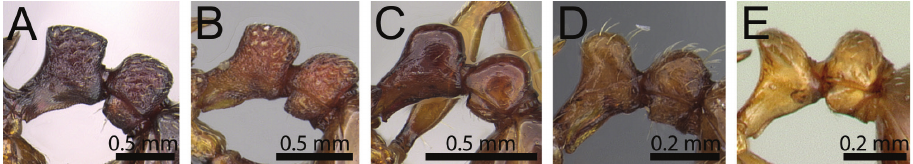
Figure 11. Petiole and postpetiole in profile. A T. fhg-ants (CASENT0248302) B T. fhg-anub (CASENT0404158) C T. nassonowii (CASENT0195504) D T. naganum (CASENT0280584) E T. arte- mis (CASENT0481732). 12 Propodeum armed with short to moderately long spines (PSLI 18–25); dor- sum of head and mesosoma without any standing pilosity (Fig. 12A, B) ....... ........................................................................ T. ranarum group (in part)